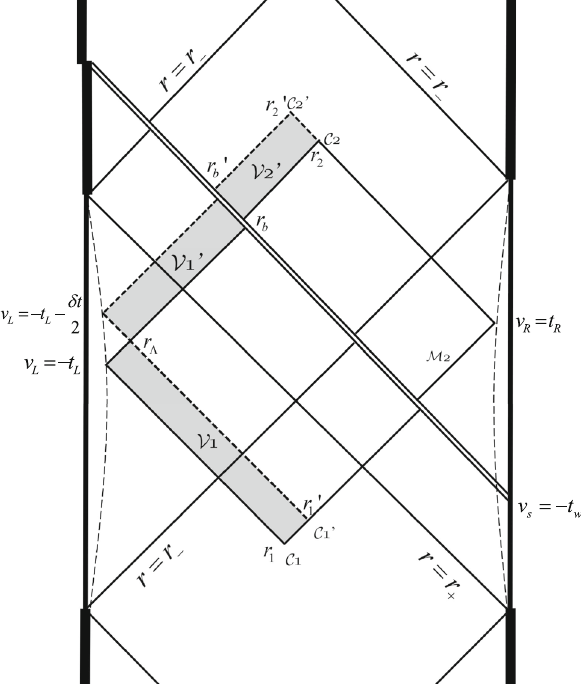
Fig. 2 The change of the Wheeler–DeWitt patches in a charged Vaidya-AdS black hole, where we fix the right boundary time t R and vary t L in the left boundary